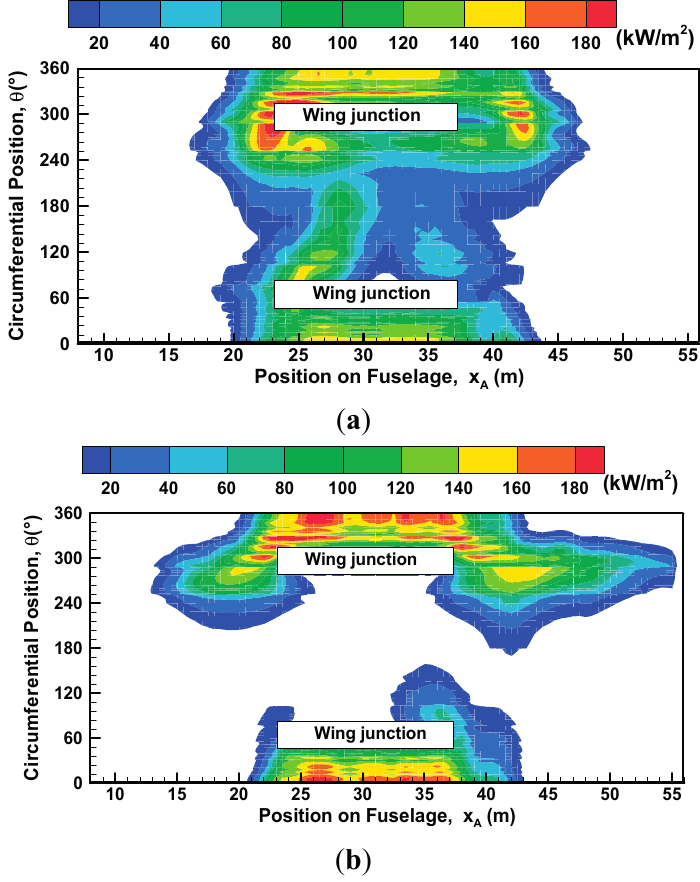
Figure 16. Iso-contour of the incident heat flux on the fuselage skin. ( a ) Wind speed of 5 m/s; ( b ) wind speed of 10 m/s.